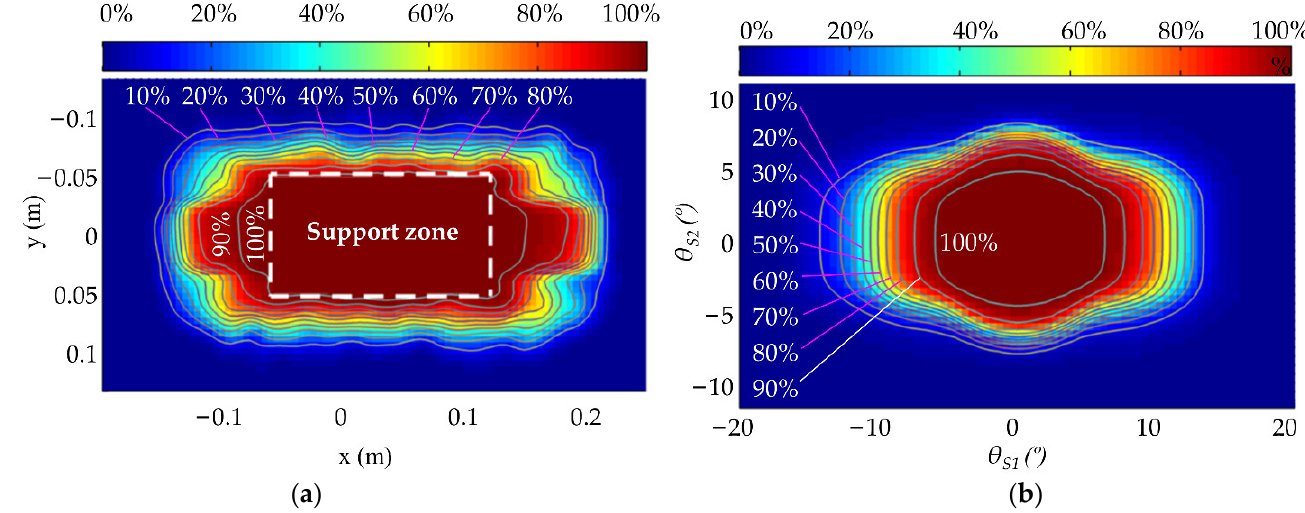
Figure 15. Success rate contour map of single-leg stance simulation with impact. ( a ) Success rate with respect to ZMP; ( b ) success rate with respect to flip angle.